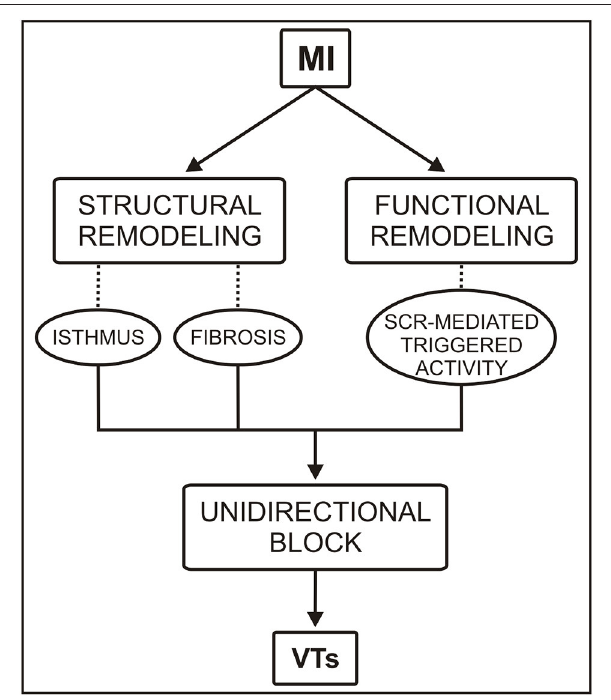
FIGURE 1 | Conceptual diagram of the roles of functional and structural remodeling involved in a portion of ventricular tachycardias (VTs) following myocardial infarction (MI). SCR = spontaneous Ca 2 +